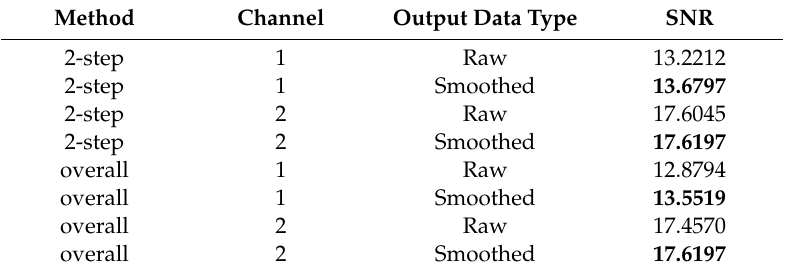
Table 6. Optimal SNR values of MISO models associated to ASTANK2